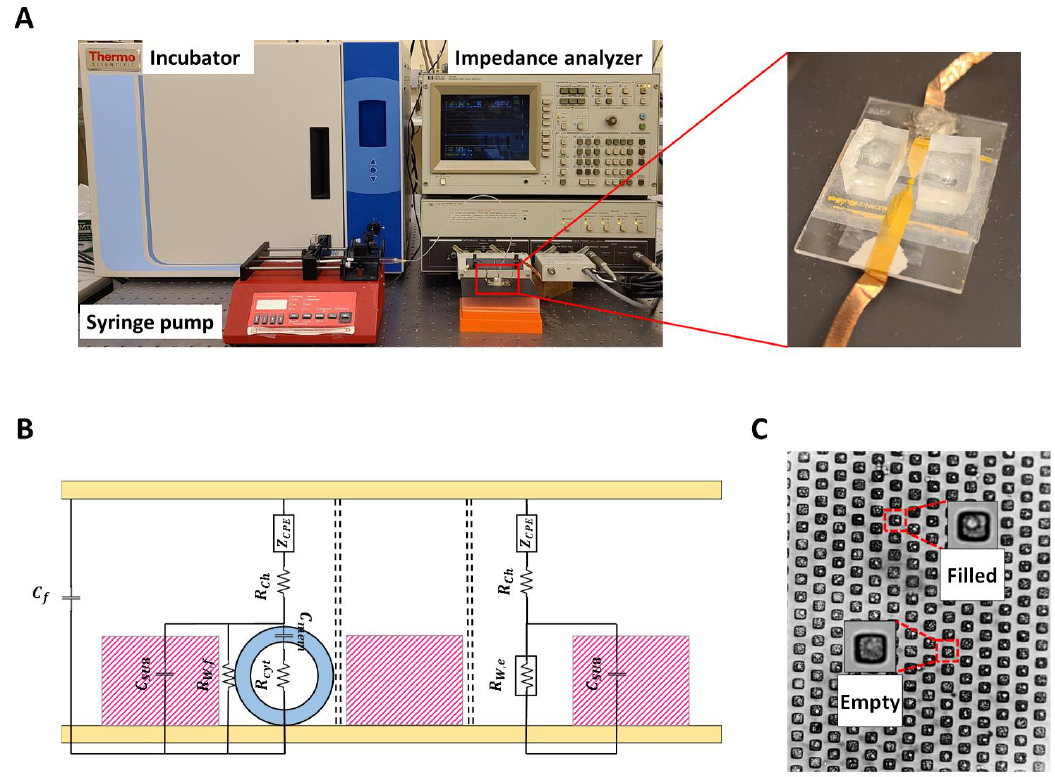
Figure 1. ( A ) Experimental setup and microchip. ( B ) Schematic of the circuit model that consists of all electrical components. ( C ) A view of the microchip showing the biological cells captured with gravitational force and empty